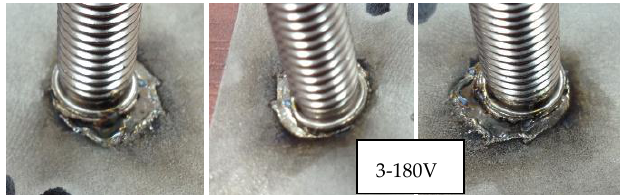
Figure 8. Visual inspection images of samples: 1-140 V, 2-160 V, and 3-180 V according to ISO 14555.